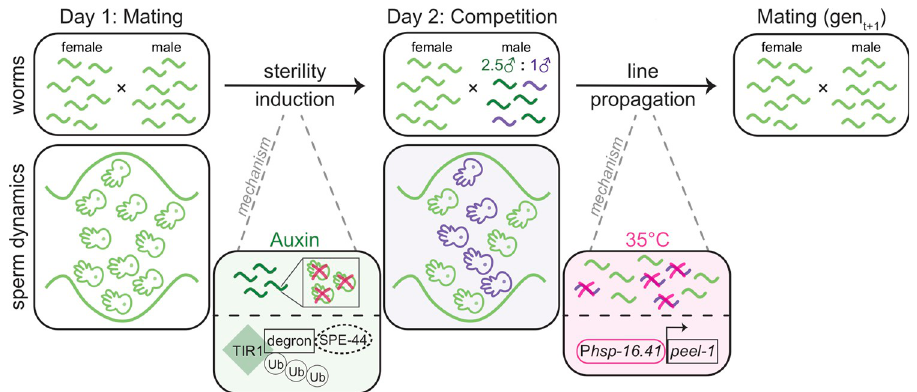
Fig 1. Day-by-day depiction of the experimental evolution design shown at the population level and at the sperm level. On day 1 sterility is induced by transferring worms to auxin-containing media. Auxin activates TIR1 to target the degron tag on SPE-44. The depletion of SPE-44 stops the production of sperm thereby inducing sterility. Females start laying eggs on day 1, using sperm from experimental males. On day 2, competitor males are added to the population at a ratio of 1 competitor male to 2.5 experimental males. Progeny are collected on day 3 from eggs laid on day 2 and then heat-shocked on day 4 to induce ectopic expression of the toxic protein PEEL-1. This expression kills competitor cross-progeny, leaving only the progeny from sperm transferred during the day 1 mating phase. Each selective event is followed by a recovery